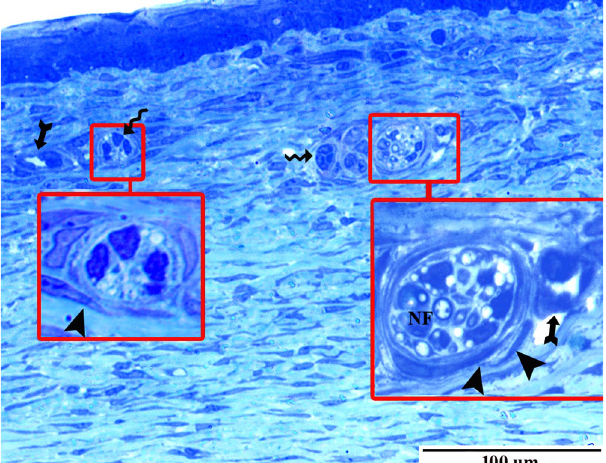
Figure 5. Semi-thin section of PND30 stained with toluidine blue showing a presence of epithelial cell clusters within the stroma of the limbus (wavy arrow) located nearby blood vessels (forked arrow) and nerve fibers (NF) and surrounded by telocytes (arrowhead).